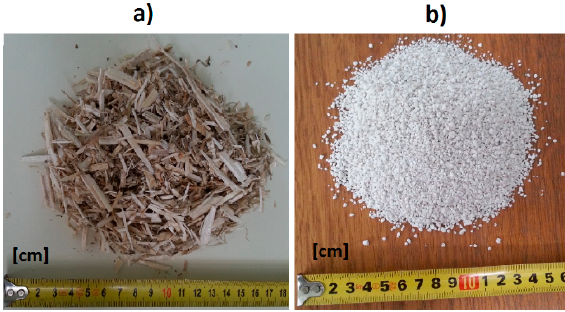
Figure 2. Fillers in composites: ( a ) hemp shives, ( b ) expanded perlite.